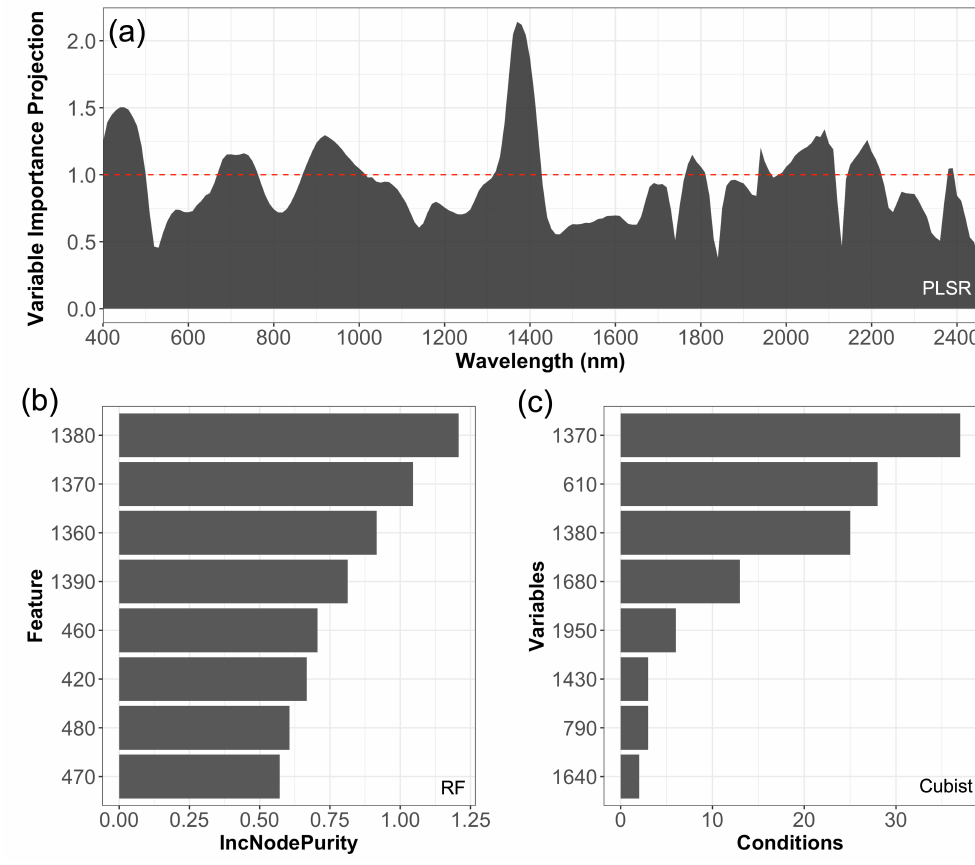
Figure 5. The variables’ importance of models for EC from PLSR ( a ), RF ( b ), and C UBIST ( c